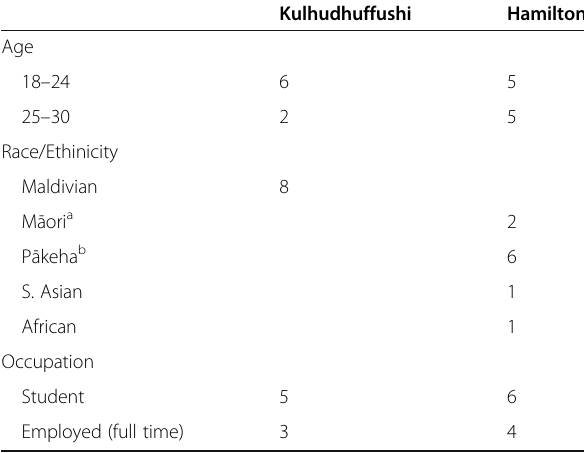
Table 1 Participants ’ demographic